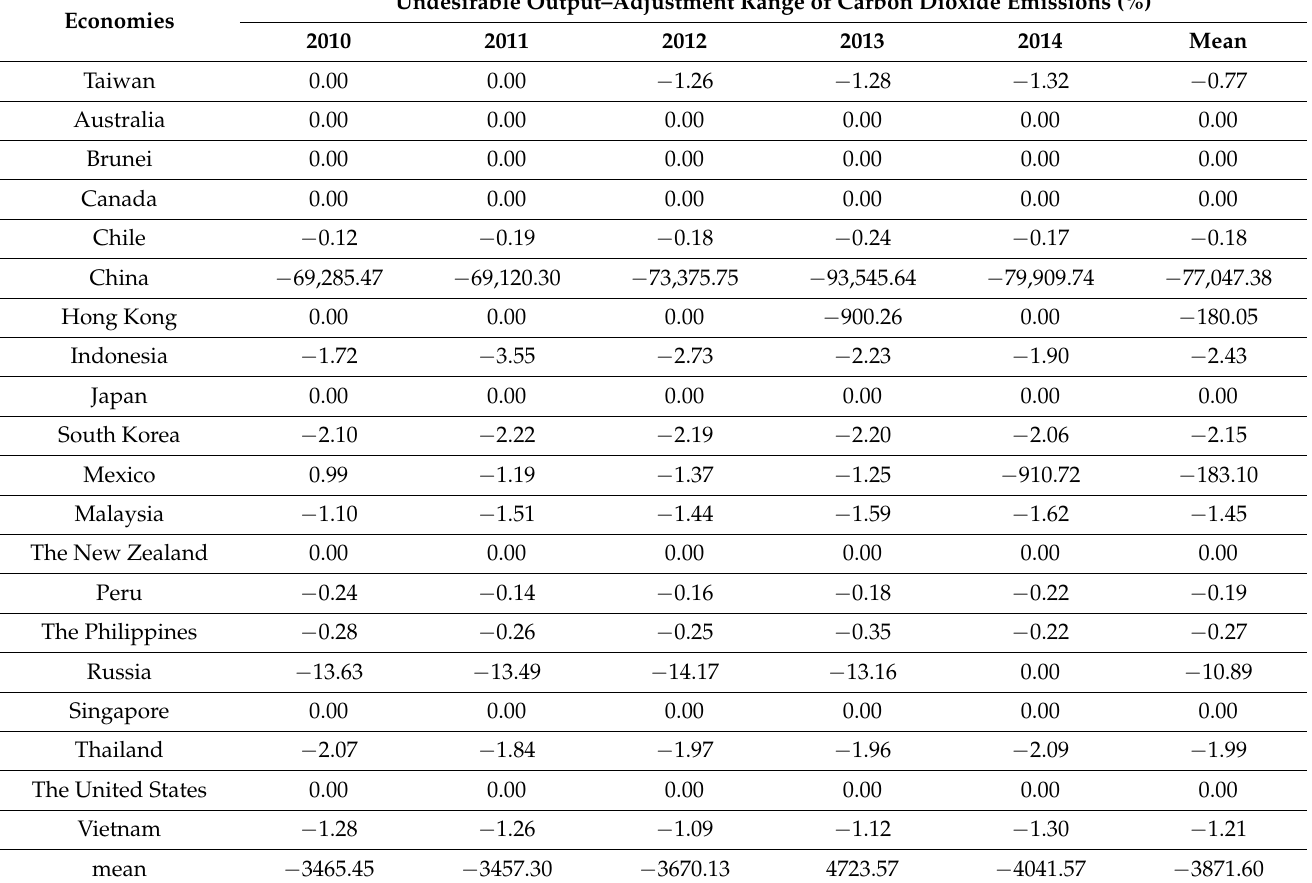
Table 8. The adjustment of undesirable output for APEC economies between 2010 and